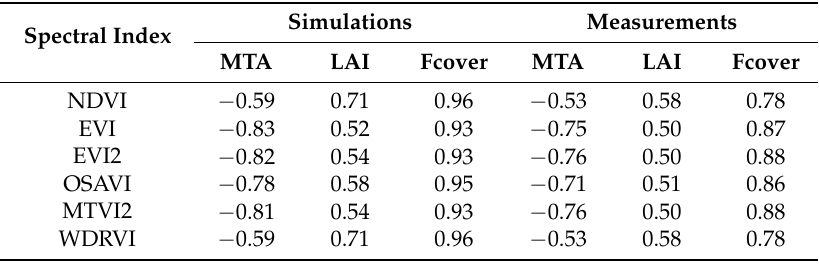
Table 2. Spearman’s correlation coefficient ( R s ) between spectral indices and canopy structural variables. Simulations Measurements Spectral Index MTA LAI Fcover MTA LAI Fcover NDVI − 0.59 0.71 0.96 − 0.53 0.58 0.78 EVI − 0.83 0.52 0.93 − 0.75 0.50 0.87 EVI2 − 0.82 0.54 0.93 − 0.76 0.50 0.88 OSAVI − 0.78 0.58 0.95 − 0.71 0.51 0.86 MTVI2 − 0.81 0.54 0.93 − 0.76 0.50 0.88 WDRVI − 0.59 0.71 0.96